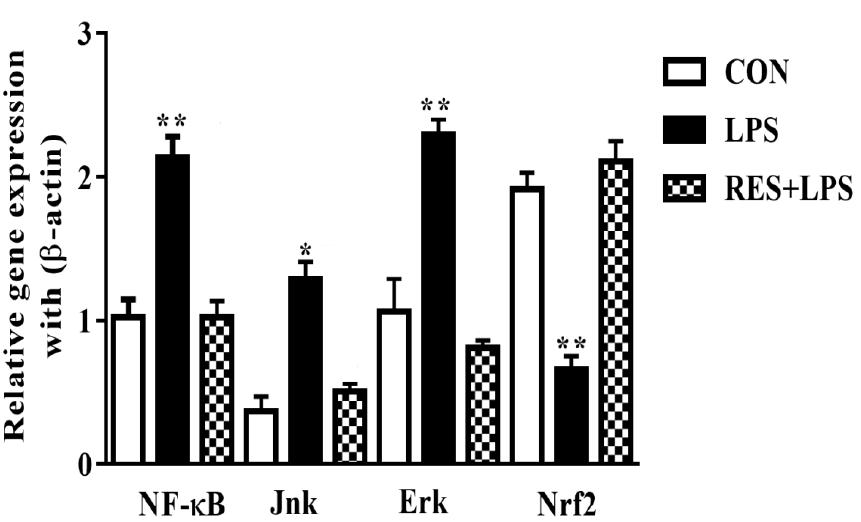
Figure 5. The mRNA expressions of NF- κ B, Jnk, Erk, and Nrf2 in mammary tissue of female mice. NF- κ B, JNK, and ERK levels were significantly different in the LPS group, while the Nrf2 mRNA expressions were significantly different in the LPS group in contrast to the CON and LPS+RES groups. * p < 0.05 significant and ** p < 0.005 highly significant